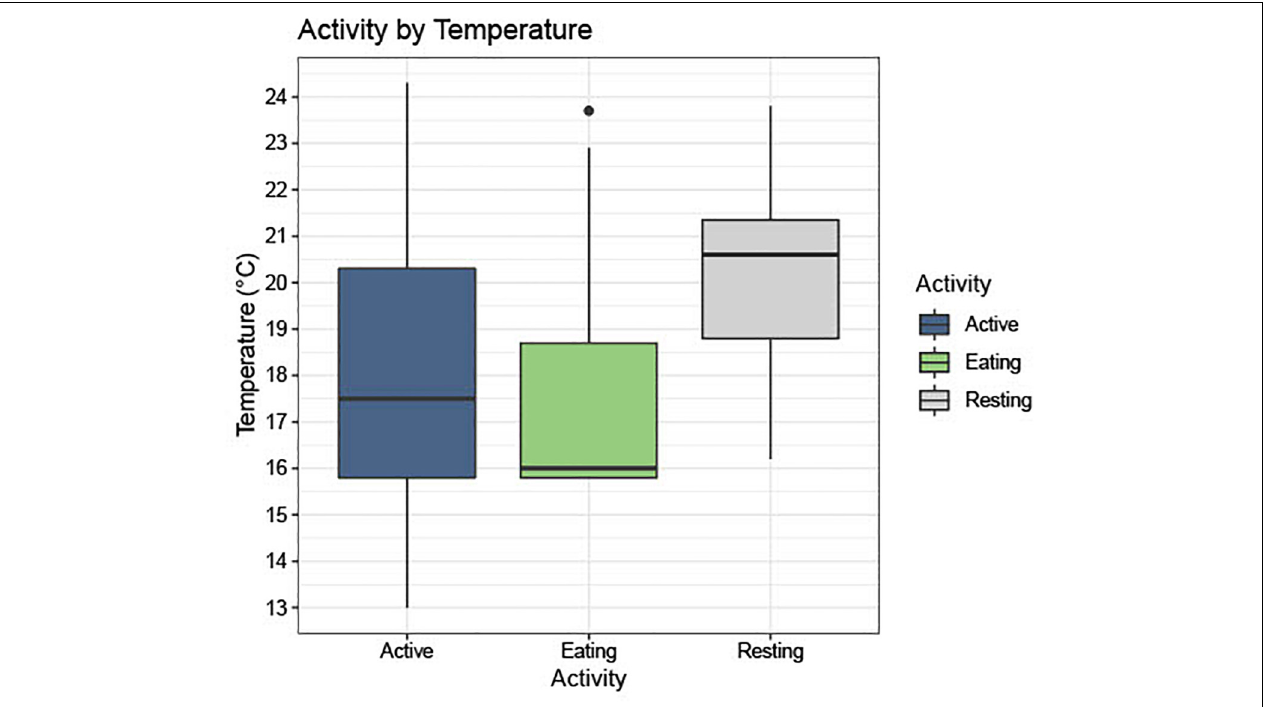
FIGURE 4 | Shows a boxplot with photographs separated into three activity categories, “Active (Active),” “Eating (Foraging),” and “Resting,” and the frequency of these activities across the range of temperatures seen in the study site (13.0–23.7 ◦ C).